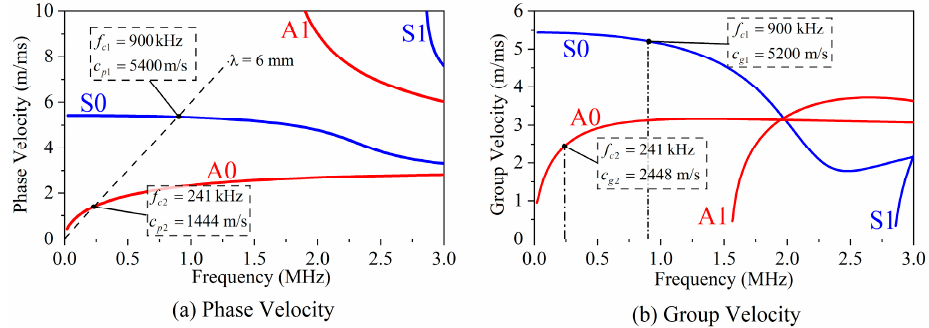
Figure 2. Lamb waves dispersion curves in a 1-mm-thick aluminium plate.